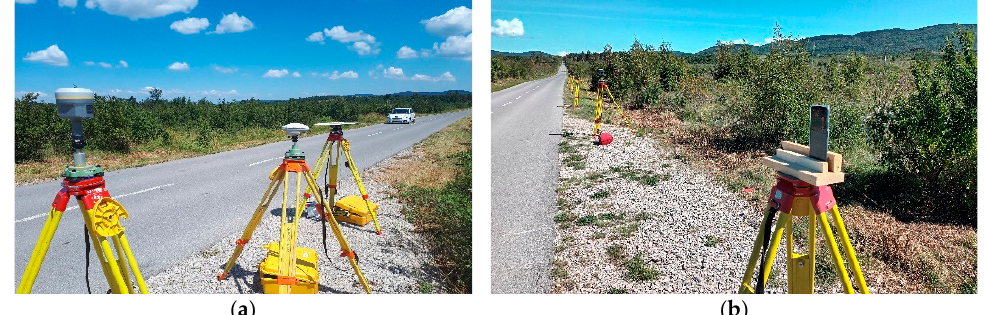
Figure 4 . Test site in Č rnoti č e, Slovenia: ( a ) testing professional geodetic receivers in 2019; and ( b ) Figure 4. Test site in ˇCrnotiˇce, Slovenia: ( a ) testing professional geodetic receivers in 2019; and simultaneously testing smartphones and geodetic receivers in 2022. ( b ) simultaneously testing smartphones and geodetic receivers in